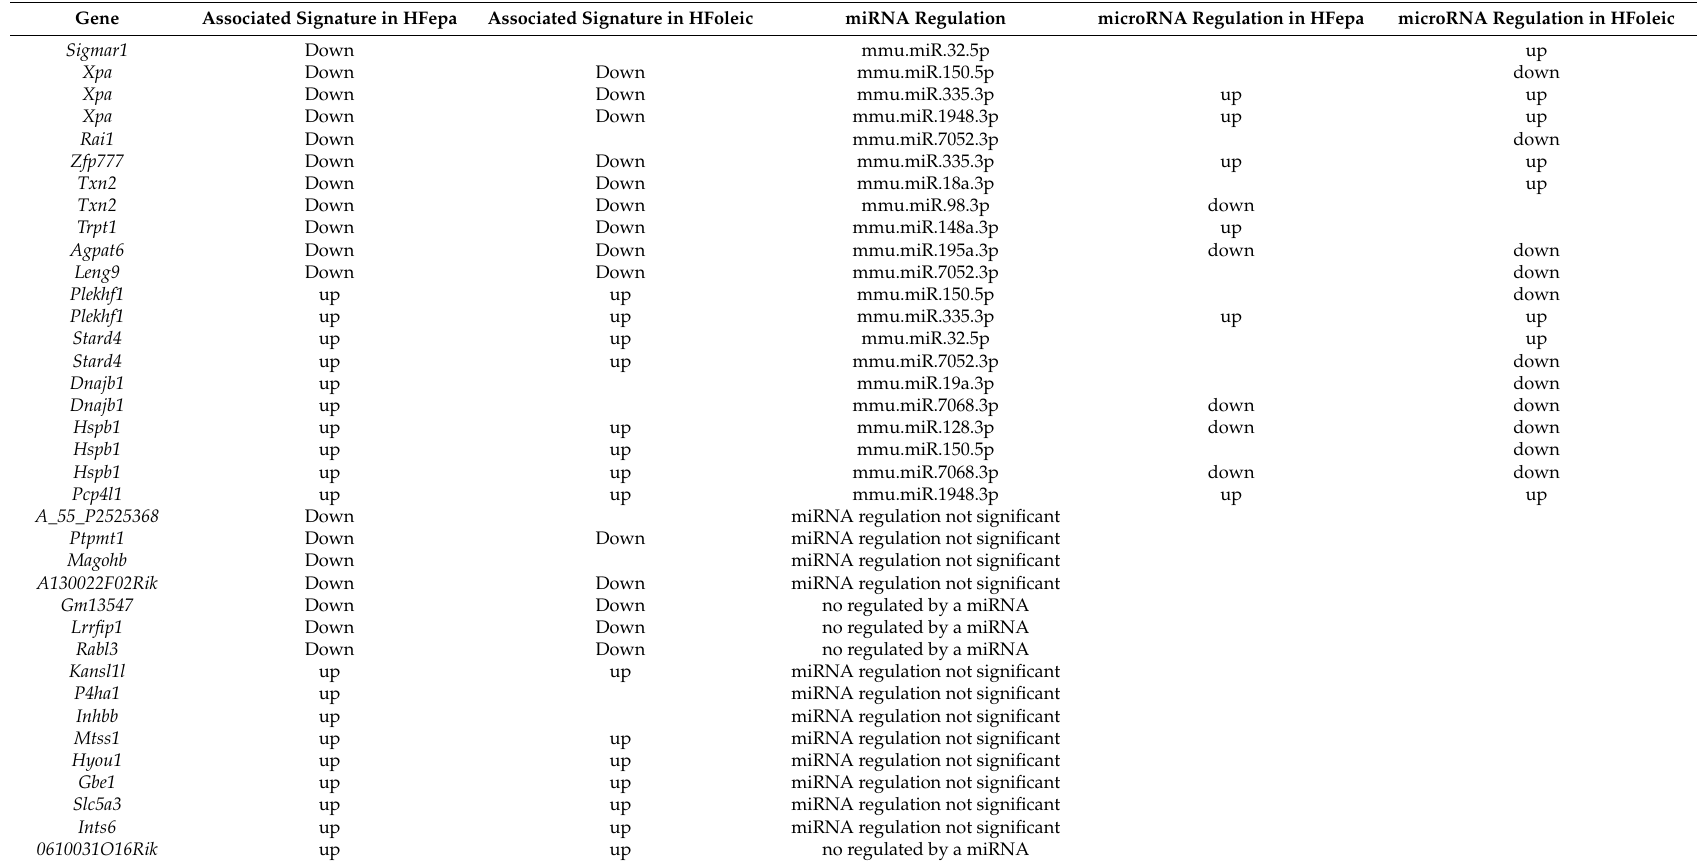
Table 2. Di ff erentially expressed genes are regulated by